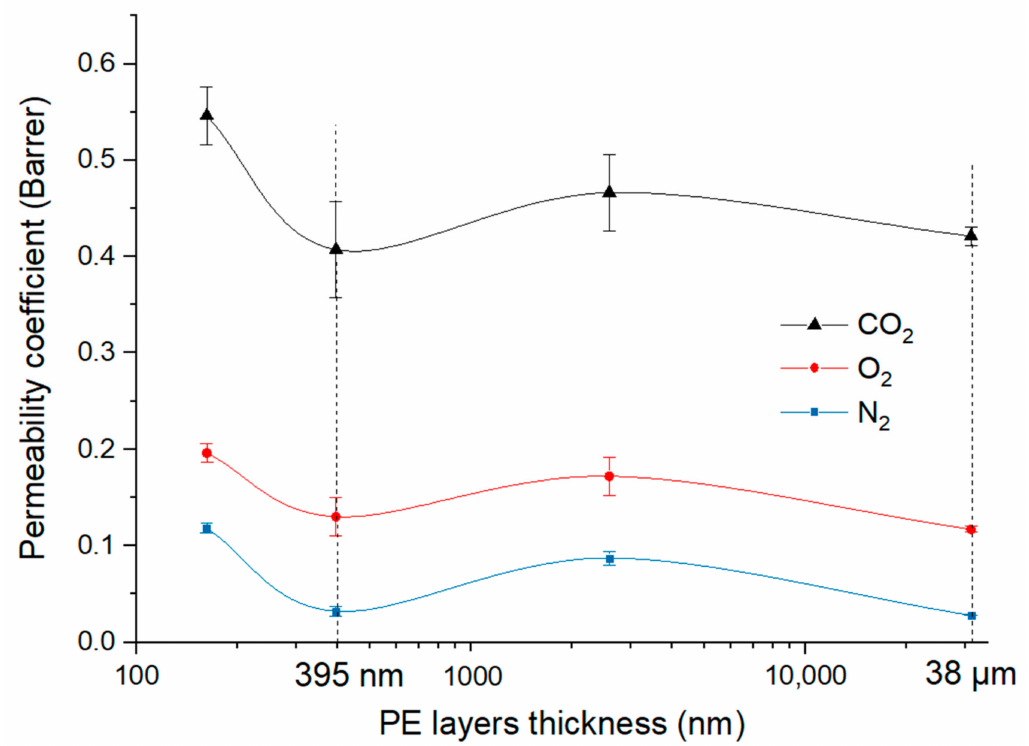
Figure 8. The gas permeability of PE/PEgMA/PA6 multilayer films as a function of PE (mixed PE/PEgMa) layer